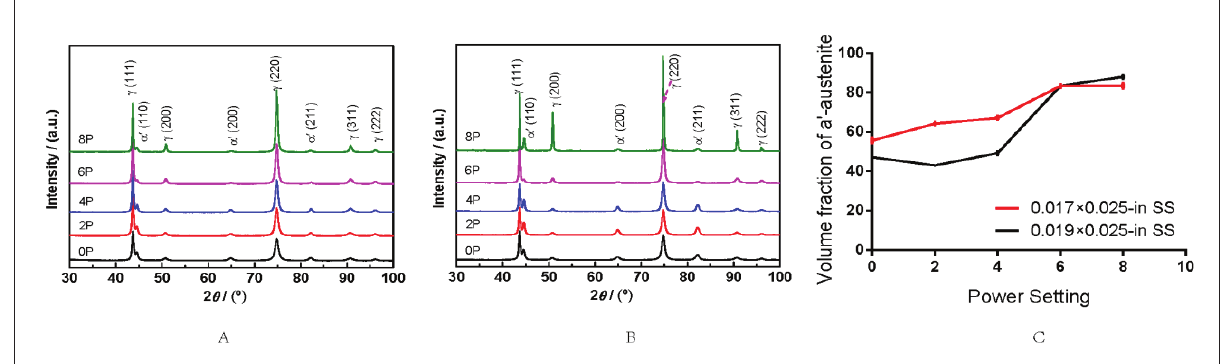
Figure 5. (A) XRD spectra of the unheated 0.017 × 0.025 inch SS wire specimens and specimens heated at power settings of 2, 4, 6, and 8 for eight seconds. (B) XRD spectra of the unheated 0.019 × 0.025 inch SS wire specimens and specimens heated at power settings of 2, 4, 6, and 8 for eight seconds. (C) Changes in α ’-austenite percentages of the 0.017 × 0.025 inch SS specimens and 0.019 × 0.025 inch SS specimens heated at different power